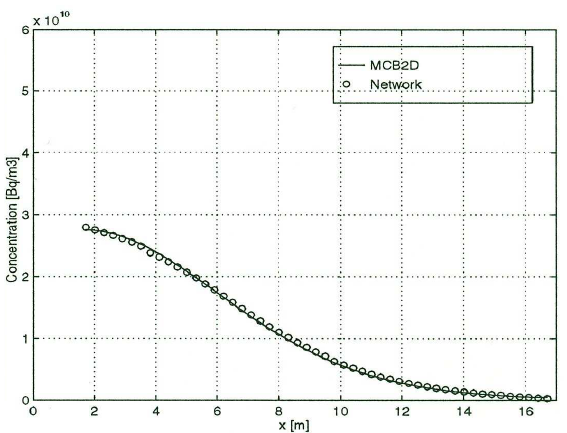
Fig. 4.6. Network 2, v/R=0.8 (cid:215) 10 -3 m/d, e test=0.36%